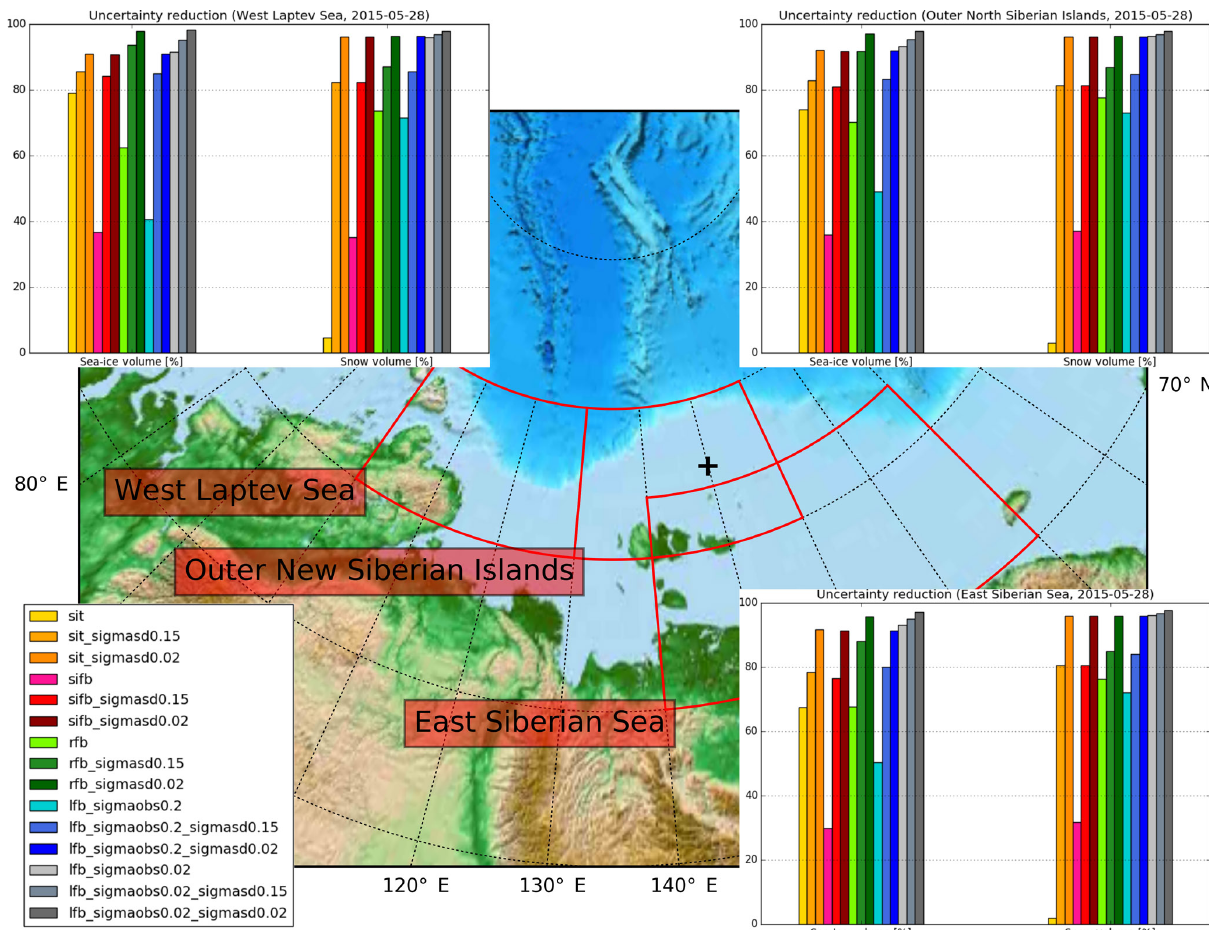
Figure 18. Uncertainty reduction for sea ice (SIV) and snow (SNV) volume over target regions when using observational constraints. The colour of the bars represents the different observational constraints. Yellowish: SIT and SIT in combination with a hypothetical snow depth product with two different uncertainties (15 and 2cm), reddish: as SIT but for SIFB, greenish: as SIT but for RFB, bluish: as SIT but for hypothetical LFB with 20cm uncertainty, greyish: as SIT but for hypothetical LFB with 2cm